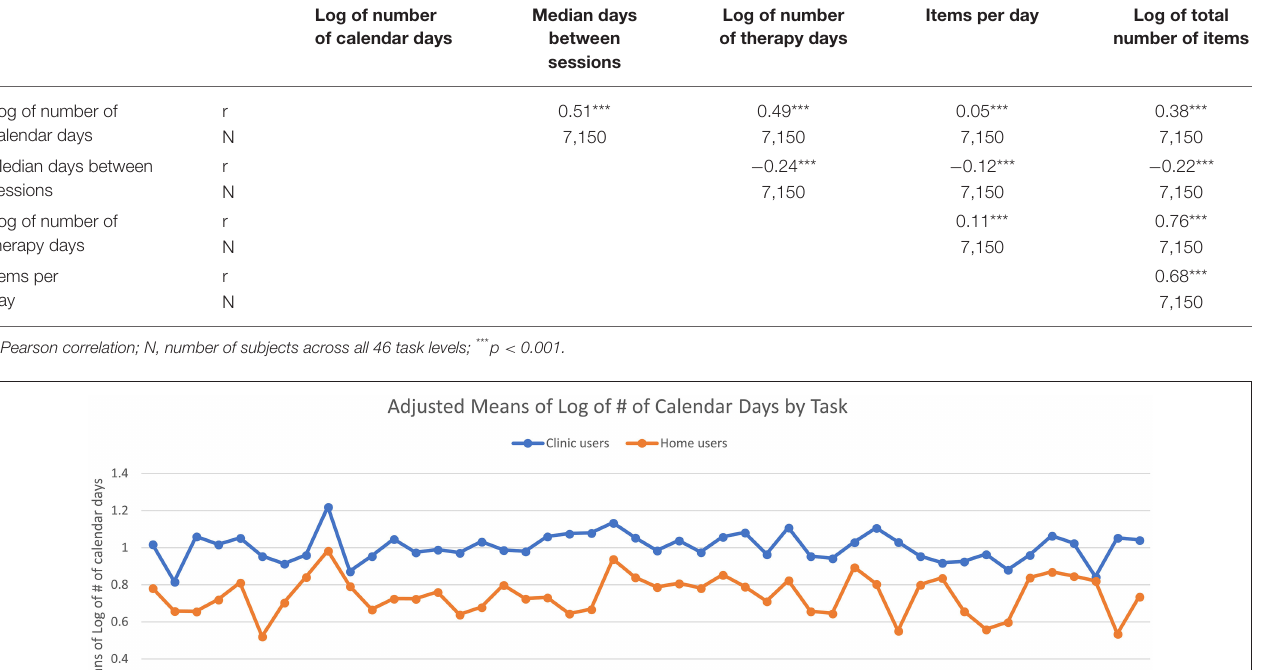
Log of number Median days Log of number Items per day Log of total of calendar days between of therapy days number of items sessions